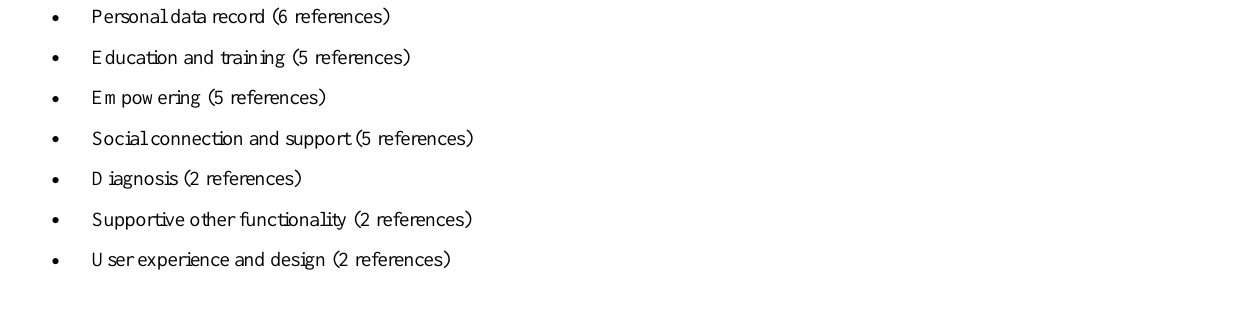
Figure 1 reflects one